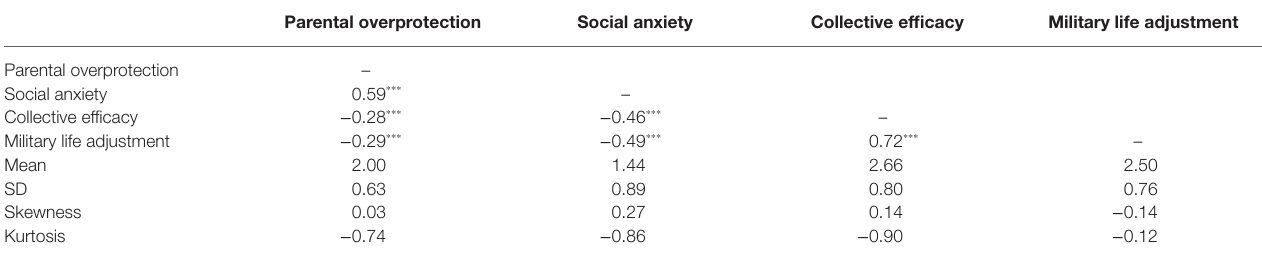
TABLE 1 | Correlation coefficients and descriptive statistics for measurement variables.